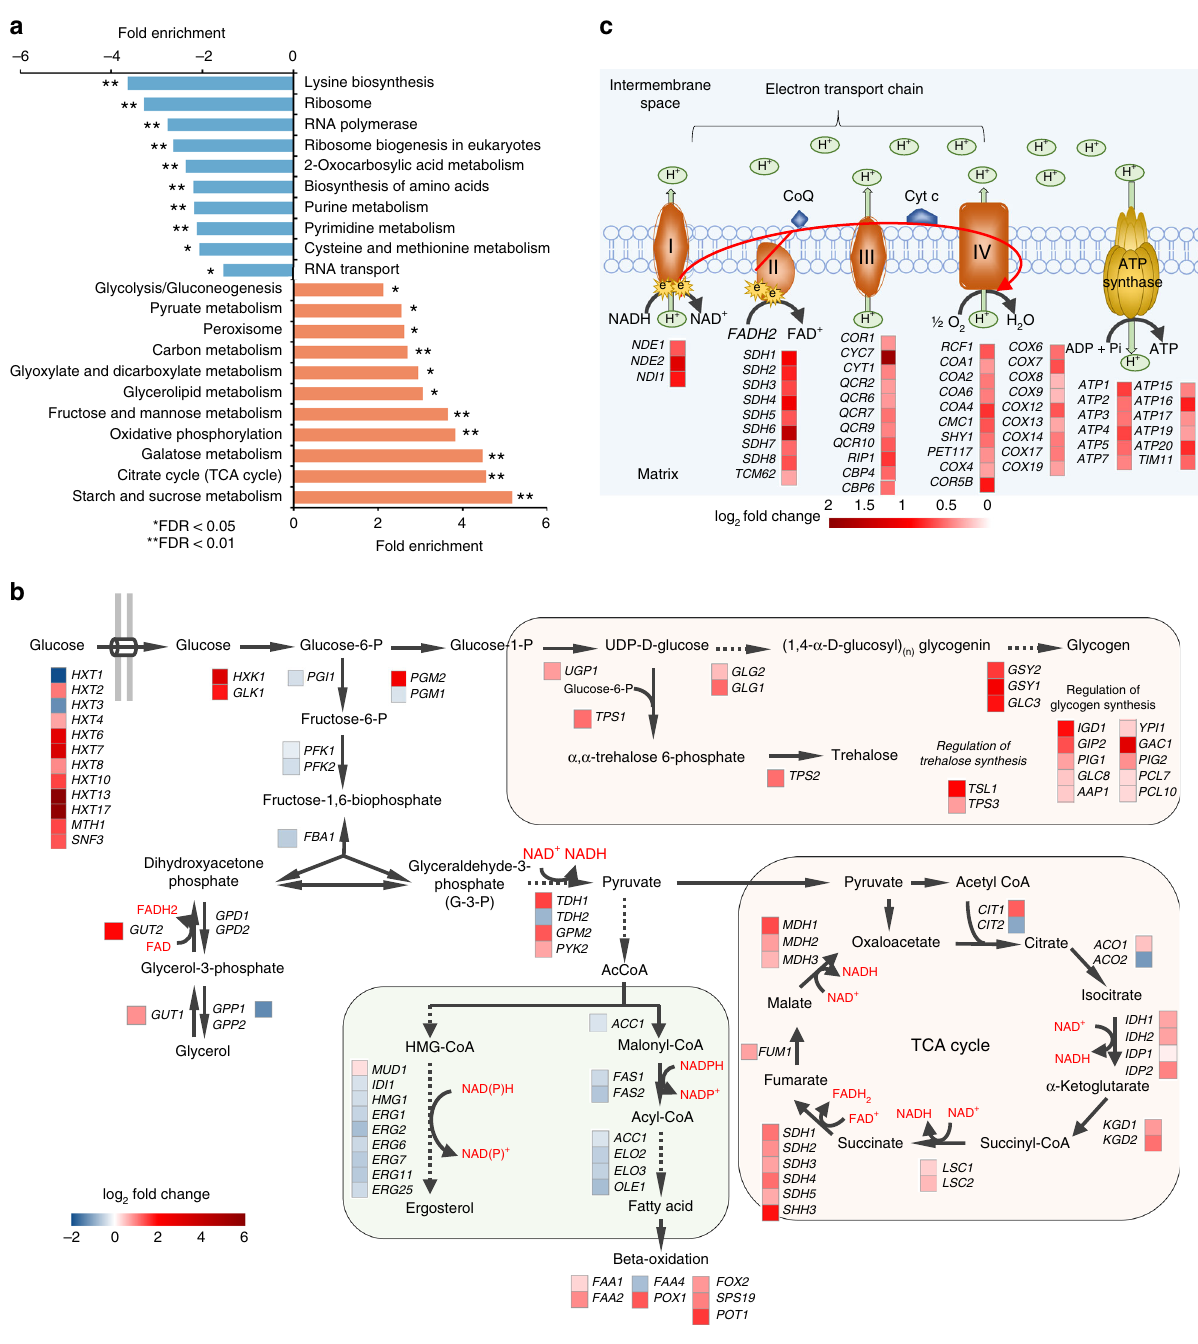
Fig. 6 Transcriptional responses in A β 42 strain with FMN supplementation. a Gene set enrichment analysis. Fold enrichment indicates the magnitude of enrichment in our dataset against the S288C yeast genome background using DAVID bioinformatics resources. b Fold changes in the expression of genes which encode central metabolic pathways. c Fold changes in expression of genes coding for mitochondrial electron transport chain proteins. All comparison is between FMN supplementation, and without ( p -adj < 0.05 according to Benjamini – Hochberg transporters ( HXT2 , HXT4 , HXT6 , and HXT7 ), and hexose transporters ( HXT8 , HXT10 , HXT13 , and HXT17 ) were upregu- lated. Most genes (20/22) in the tricarboxylic acid (TCA) cycle were also upregulated after FMN supplementation as well (Fig. 6b). The TCA cycle generates NADH and FADH 2 , which involved in ergosterol and fatty acid synthesis, the second branch the electron transport chain. Meanwhile, we found that genes reduced NADPH consumption to NADP + . This fi nding is showed signi fi cantly ( p < 0.05) increased transcription after FMN